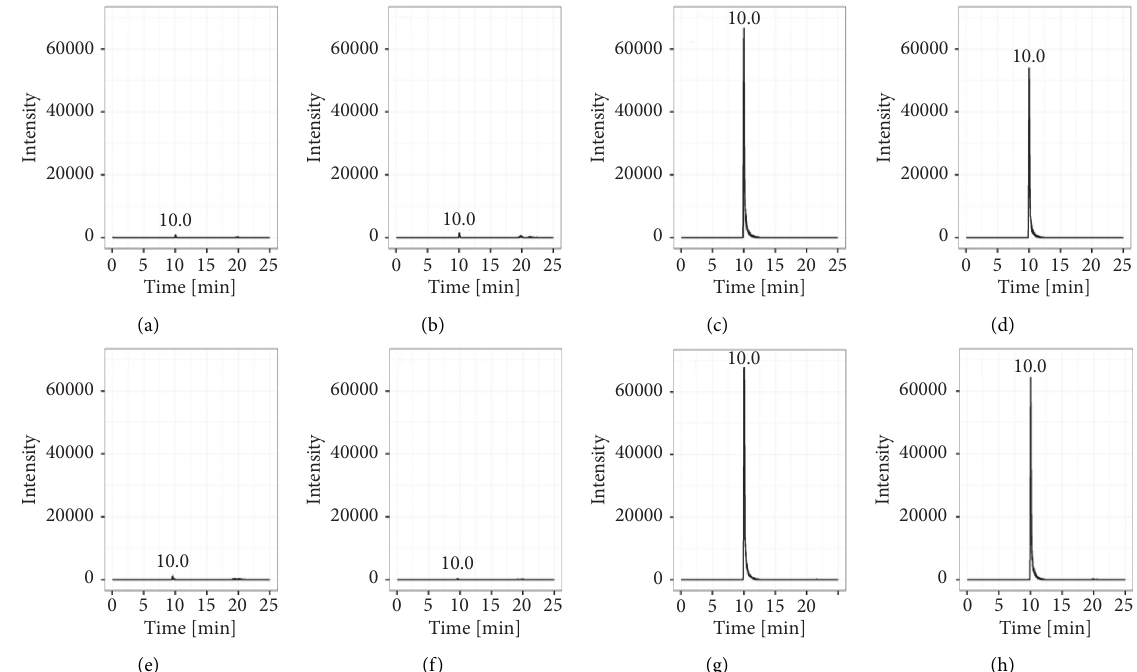
6 -dabigatran (c), breast milk